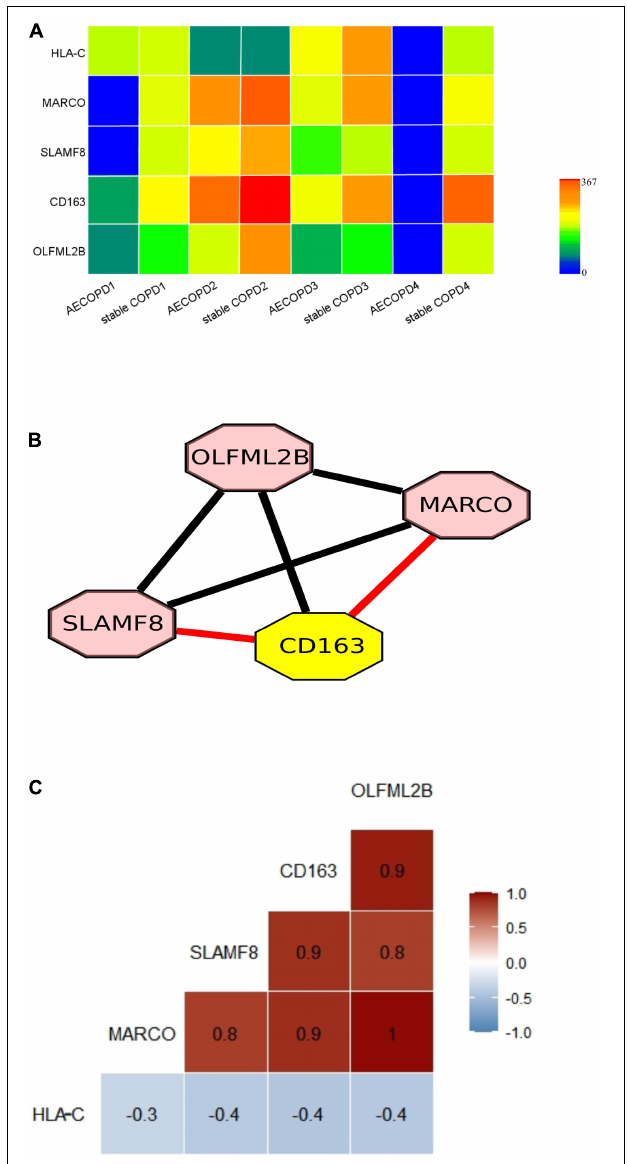
FIGURE 4 | Differentially expressed genes in AECOPD and stable COPD patients and the correlation between genes. (A) Gene expression of 5 key genes. Gene expression levels were calculated as log2 (normalized number of transcripts per million [TPM] + 0.00001). (B) The nodes represent genes. The networks of the 5 genes were built using Cytoscape. (The red line indicates that the genes are co-expression, and the result is consistent with STRING, the black line indicates that they just have correlation in Spearman coefficient). (C) The figure show Spearman correlation coefficients between the 5 genes.